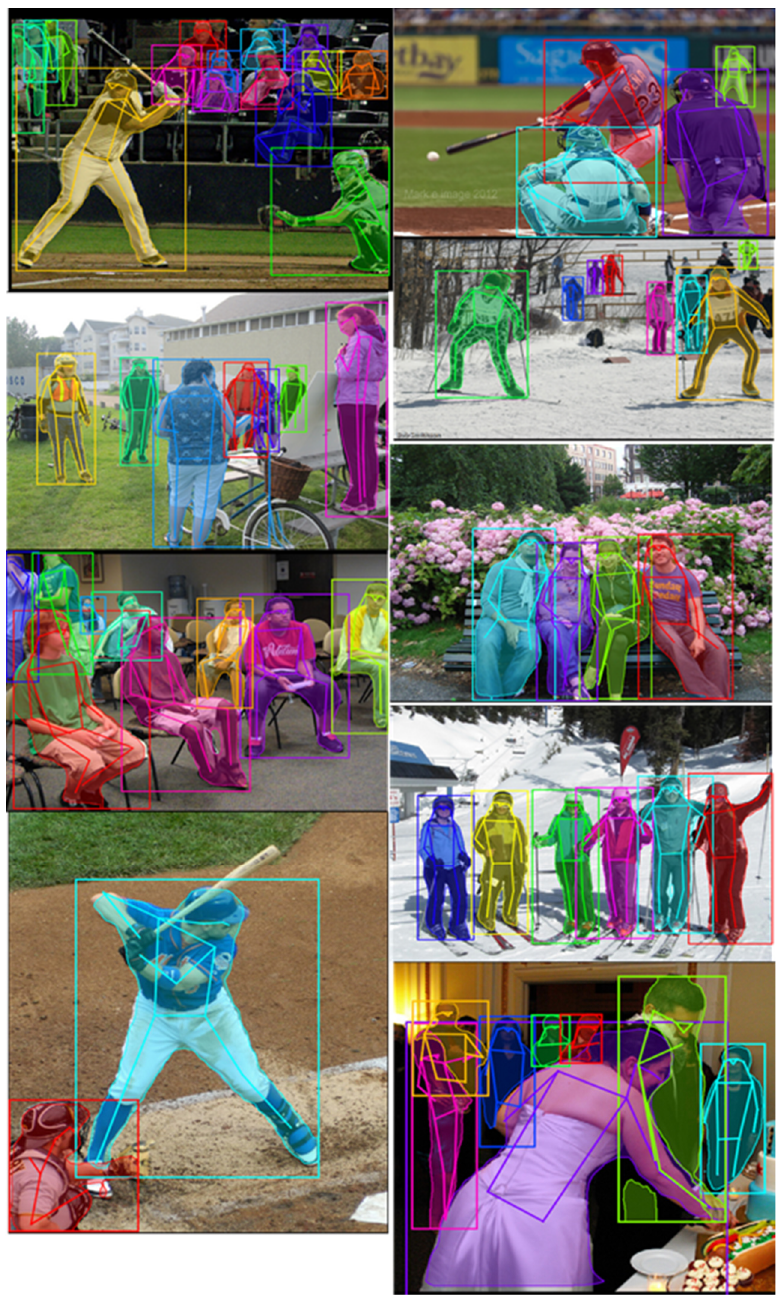
Figure 14. Body segmentation and joint position estimation results on the COCO dataset. Table 2. Evaluation for joint position estimation of proposed models using the Percentage of Correct Keypoints (PCK; %).